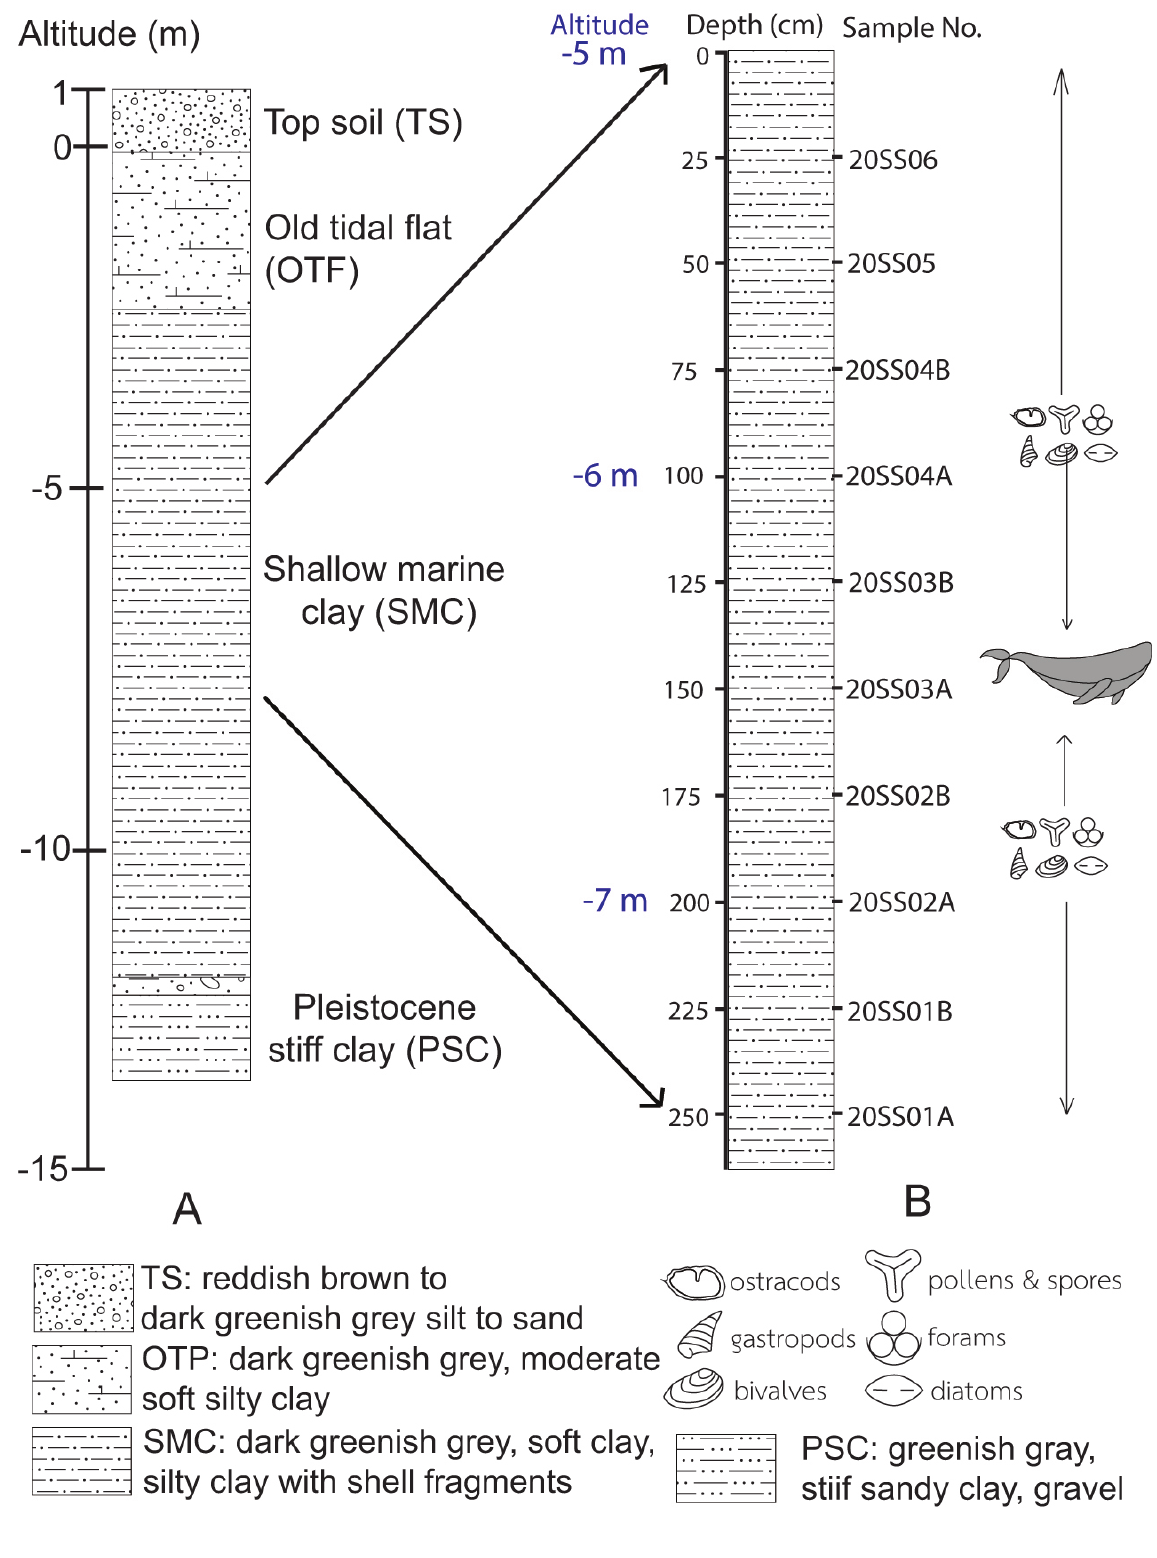
Fig. 3. Lithostratigraphy of the studied section at whale-fall excavation site in Samut Sakhon Province. A . Lithologic log modified after Nuamnim et al . (2021). B . Lithologic log of the studied section (this